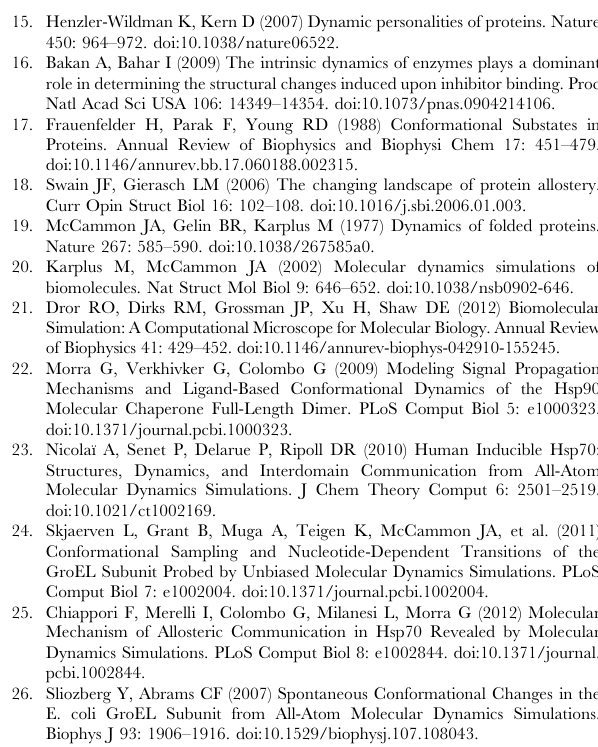
Figure S6 Effective FEPs V( c ) of ATP-bound DnaK in k B T units for the network of 27 CGDAs c . The values of V( c ) for the most probable representative structure extracted from the MD runs ATP1 ( A 3 ) and ATP2 ( B 3 ) are shown with diamonds and triangles, respectively. The FEPs V( c ) were translated between 2 180 u and + 180 u compared with Fig. S4. Figure S7 Trajectory along the PME (for the MD run ATP1) of each CGDA c i (s j ) and their corresponding FEP V( c i ) . Minima and saddle points along the PME (Fig. 9) are represented by gray and red diamonds, respectively. The green diamond corresponds to the minimum A 3 . Figure S8 Dihedral principal component analysis ap- plied to MD simulations of ATP-bound DnaK. Influences D i1 and D i2 of the 27 CGDAs c extracted from dPCA of the MD run ATP1. The dashed line represents an influence of 10%. Figure S9 Representative structures of the minima and of the saddle points observed along the PME on the FES computed from dPCA applied to the MD run ATP1. At each step s j , the CGDAs c i which have the same conformation as observed in the minimum A 3 are represented by green spheres and the others by red spheres. The ATP nucleotide is shown in blue spheres. These figures were prepared with PyMOL [http://www.